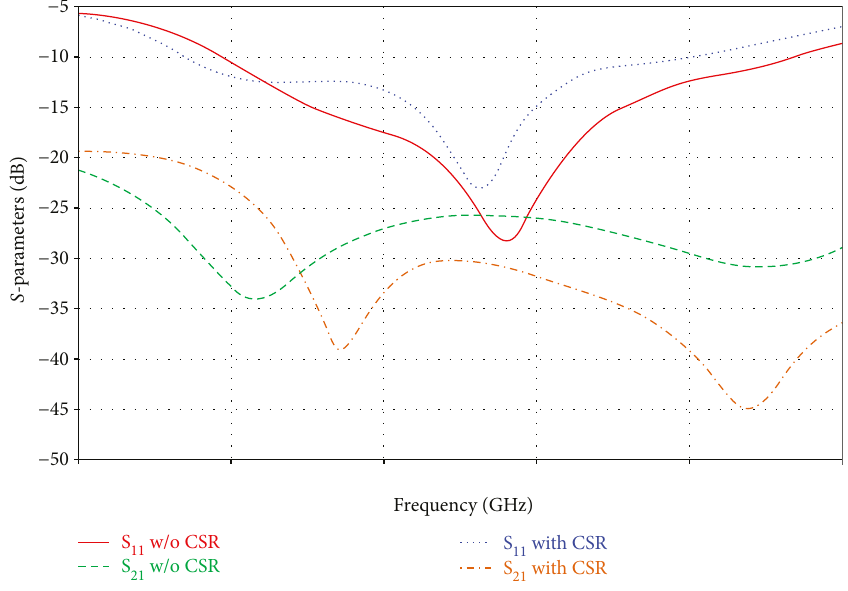
Figure 15: Comparison between simulated S -parameters with and without CSR matrix